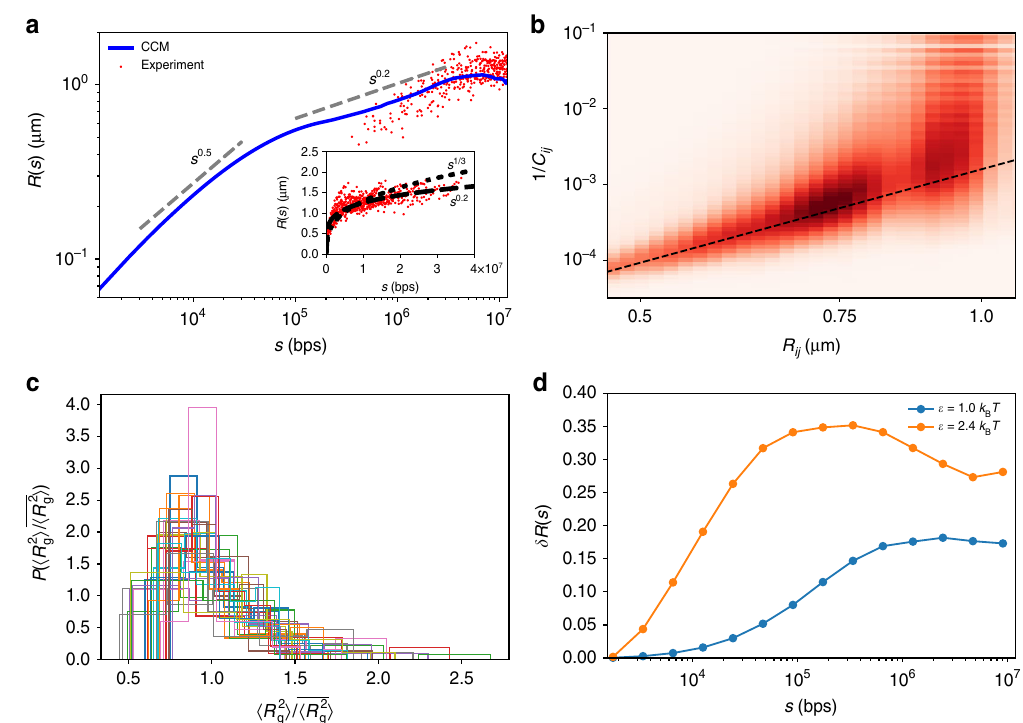
Fig. 3 Organization and fl uctuations of the chromosome structures. a The dependence of the spatial distance R ( s ) (Eq.1) on the genomic distance, s . Gray dashed lines, indicating the slopes, are guides to the eye. The red dots are experimental data taken from 6 for s < 1.2×10 7 bps. The inset shows the complete set of experimental data. Short dashed and long dashed lines are s 1/3 and s 0.2 , respectively. At small s ( s < 10 5 bps), R ( s ) ~ s 0.5 implying that chromatin behaves as almost an ideal chain. b The heatmap of the 2D histogram of ( R ij ,1/ C ij ). The dashed black line is the curve with scaling exponent 4.1, which i = h R 2 iÞ , where h R 2 i is the time average value of the squared radius coincides with the value obtained by fi tting the experimental data 6 . c Distribution P ðh R 2 g g g i is the mean value averaged over all independent trajectories. Different colors represent P ðh R 2 i = h R 2 iÞ for the 32 of gyration of a single trajectory and h R 2 g g g individual TADs. The distribution is surprisingly wide, which suggests that TAD structures vary from cell-to-cell. d Coef fi cient of variation δ R ( s ) =